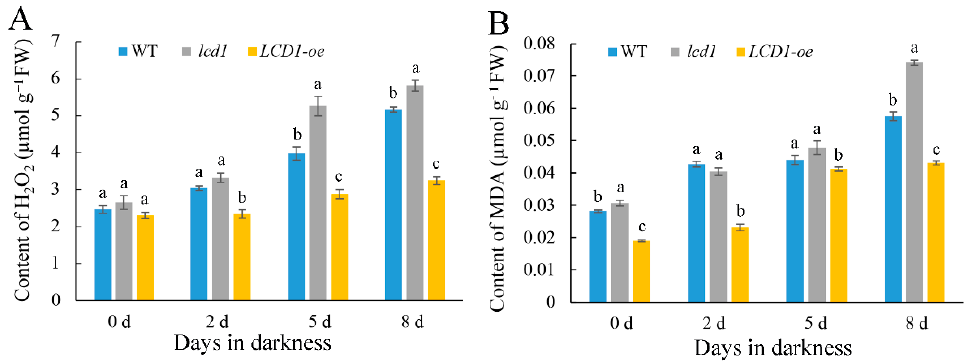
Figure 4. Changes in the contents of ( A ) H 2 O 2 and ( B ) malondialdehyde (MDA) in dark-stored detached leaves of 6-week-old wild-type (WT), lcd1 , and LCD1-oe tomatoes for 0, 2, 5, and 8 days. Data are means of three biological replicates ± standard deviation (SD). Different letters above the columns stand for significant difference between two values ( p < 0.05) at the same time point. 2.4. Effect of LCD1 on the Expressions of Genes Related to Chlorophyll Degradation in Detached Tomato Leaves